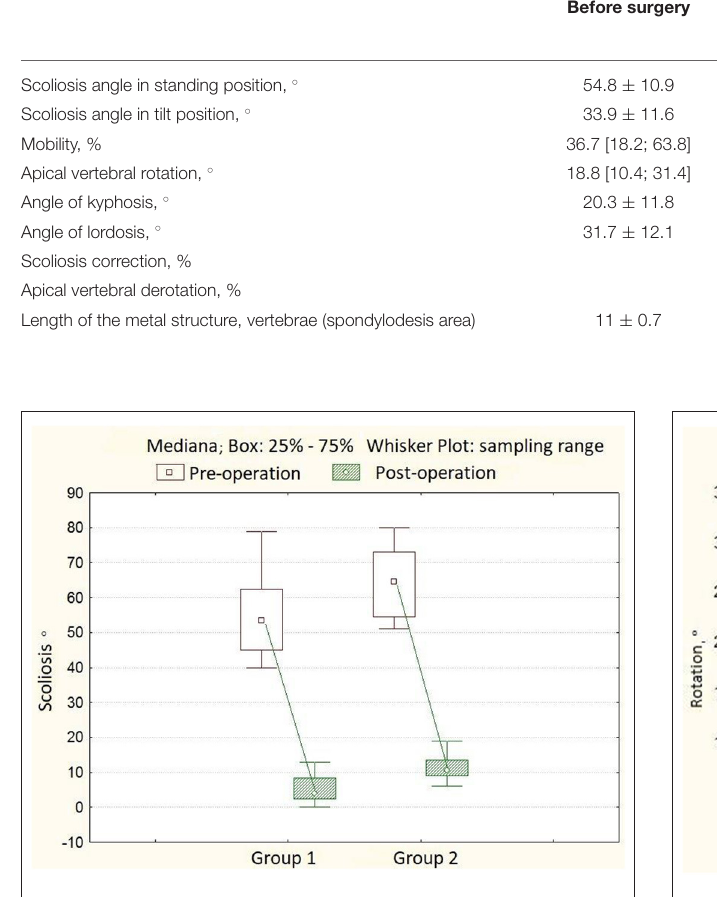
FIGURE 1 | A boxplot showing the dynamics of scoliosis angles in patients from groups 1 and 2.